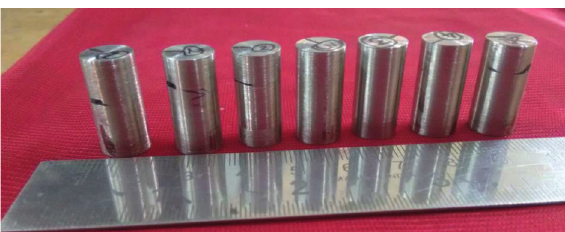
Figure 4: Pin-on-disc samples extracted from laser hardfaced deposit.